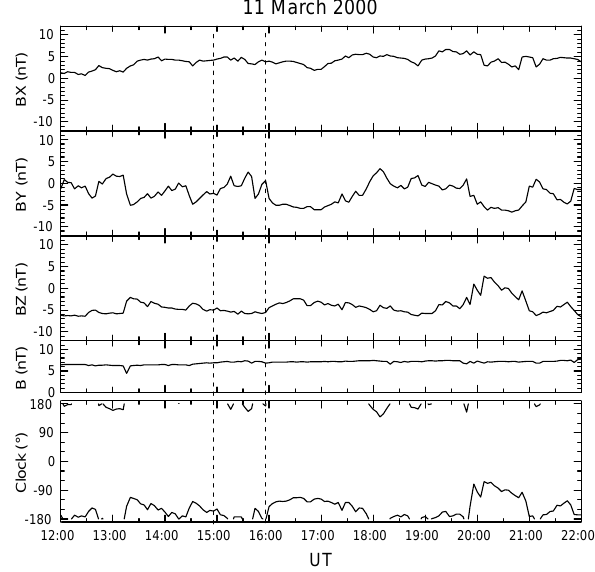
Fig. 1. Interplanetary magnetic field data in GSM coordinates for 11 March 2000 from the ACE spacecraft. Vertical dashed lines show the approximate period of time at ACE that corresponds to the solar wind at Earth during the 16:00–17:00 UT interval ana- lyzed here. Solar wind data are not available after 04:00 UT on this